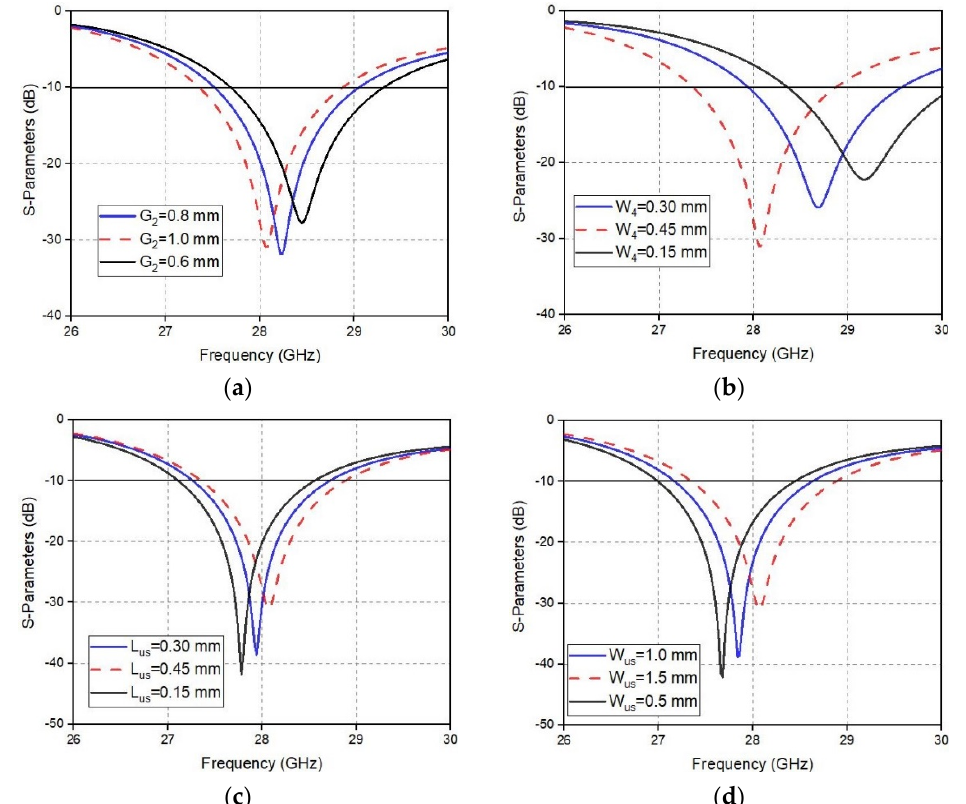
Figure 4. Parametric analysis of ( a ) Left slit length; ( b ) Left slit width; ( c ) Top slit length; ( d ) Top slit width.